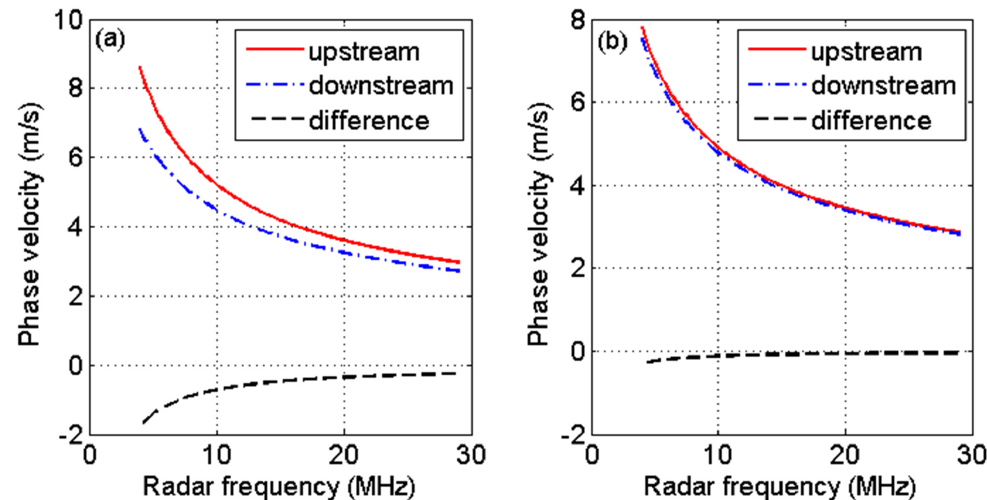
Figure 9. Intrinsic phase speeds of surface gravity waves propagating on a shear flow. ( a ) High shear, U = 1.5 ms − 1 , d = 5 m; ( b ) Low shear, U = 0.5 ms − 1 , d = 10 m. In both cases the depth H = 200 m. The difference is plotted in the sense of downstream–upstream . The abscissa would normally be calibrated in wavenumber but, for convenience, we have converted this to the equivalent HF radar frequency corresponding to first-order Bragg resonance for backscatter geometry.